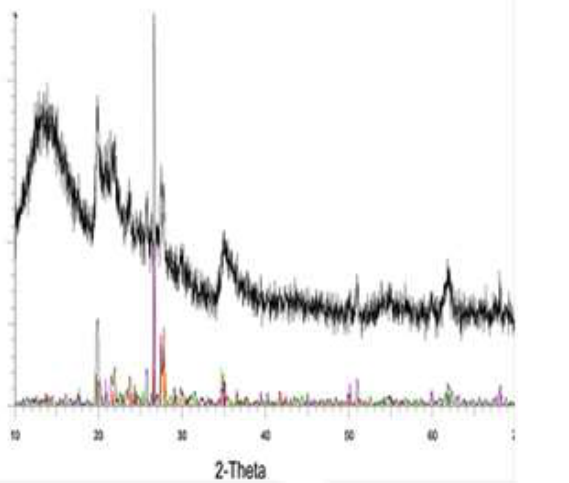
Fig.6. The effect of initial pollutant concentration on the adsorption uptake capacity of clay for Ni (II) ions and MB